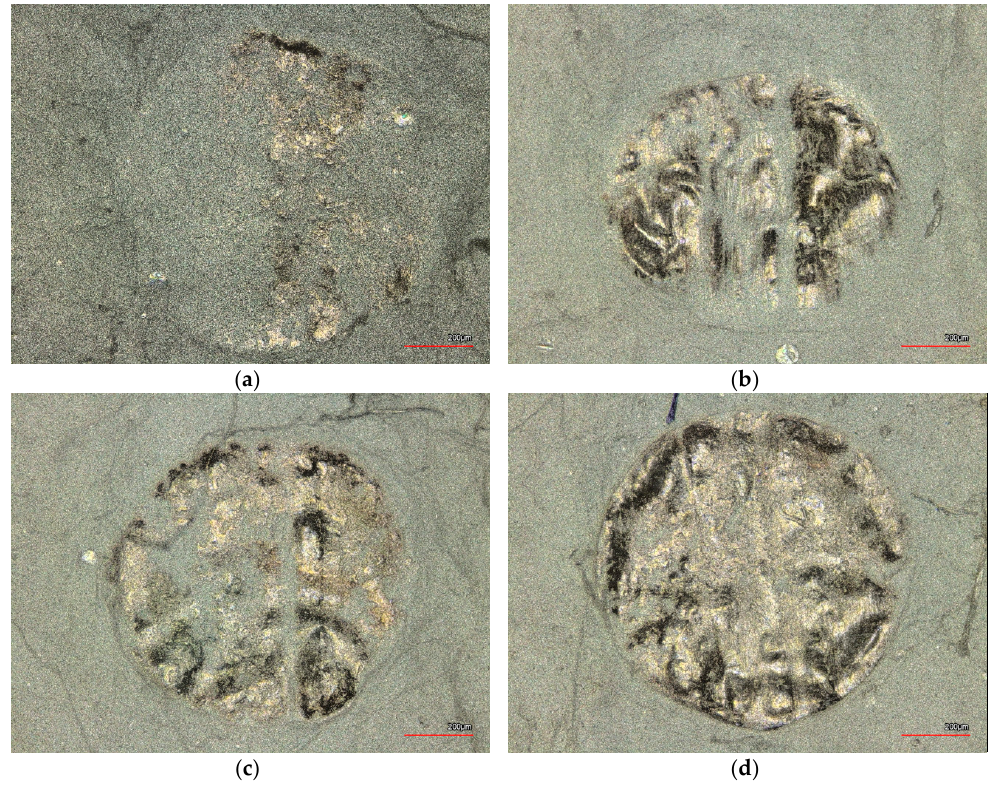
Figure 6. Confocal laser scanning microscope (CLSM) images of the ultrasonic welding seams prepared with point 2-rowed anvil wheel, a power of 750 W and different pressures: ( a ) 50% = 75 bar; ( b ) 60% = 90 bar; ( c ) 70% =105 bar; ( d ) 90% = 135